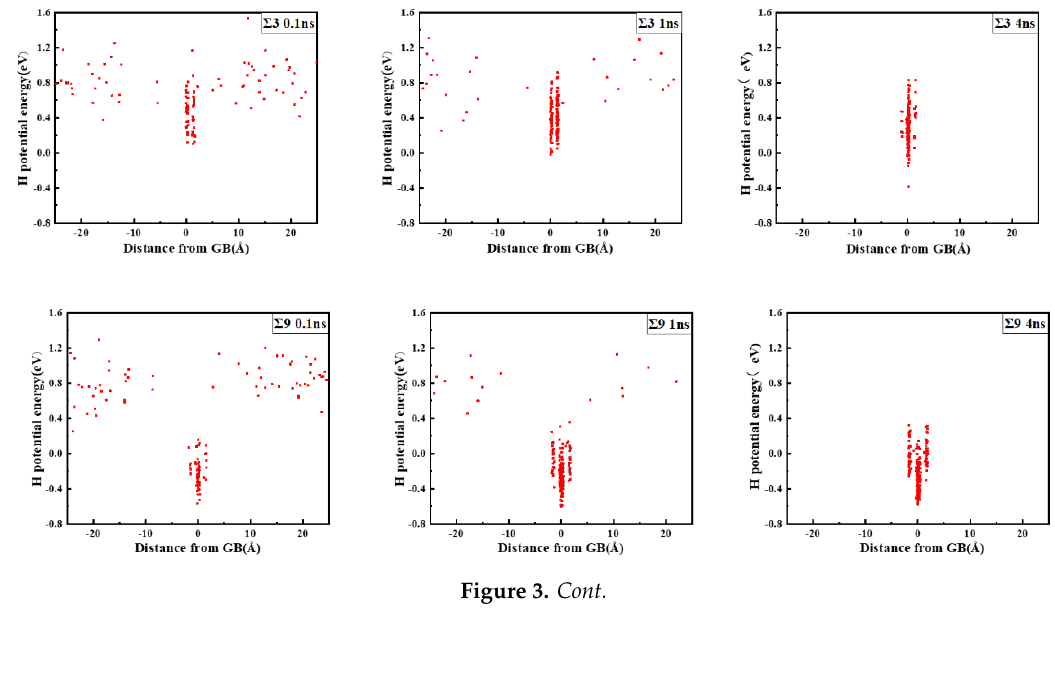
Figure 2. Correlation between GBE and volume expansion for different symmetric GBs.